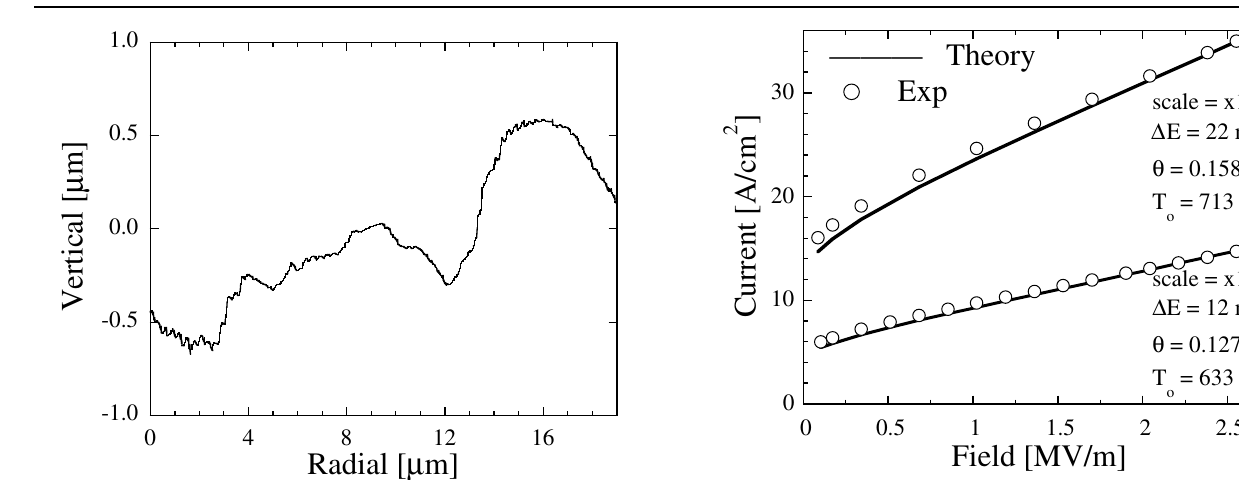
FIG. 7. Same as Fig. 6, but showing greater detail in the radial direction. Note the presence of nanoprotrusions which provide field enhancement apart from the larger scale